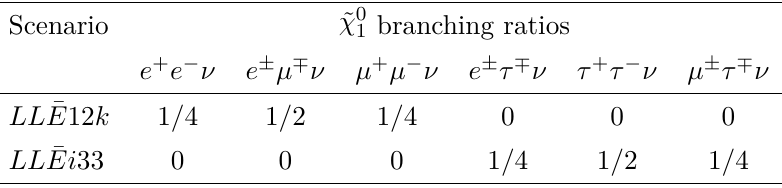
Table 1. Decay modes and branching ratios for the ˜ χ 0 1 LSP in the RPV models, where ν denotes neutrinos or antineutrinos of any lepton